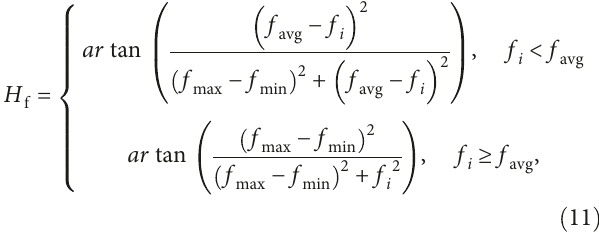
of regulatory hormone y is shown below: c y